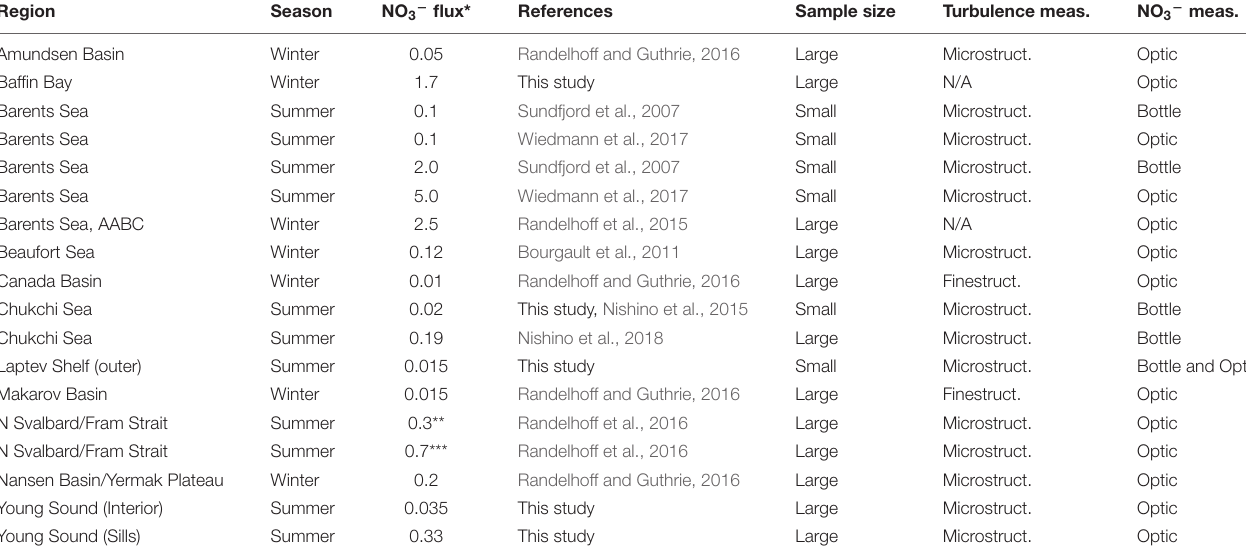
TABLE 1 | Nitrate fluxes observed in the Arctic Ocean.